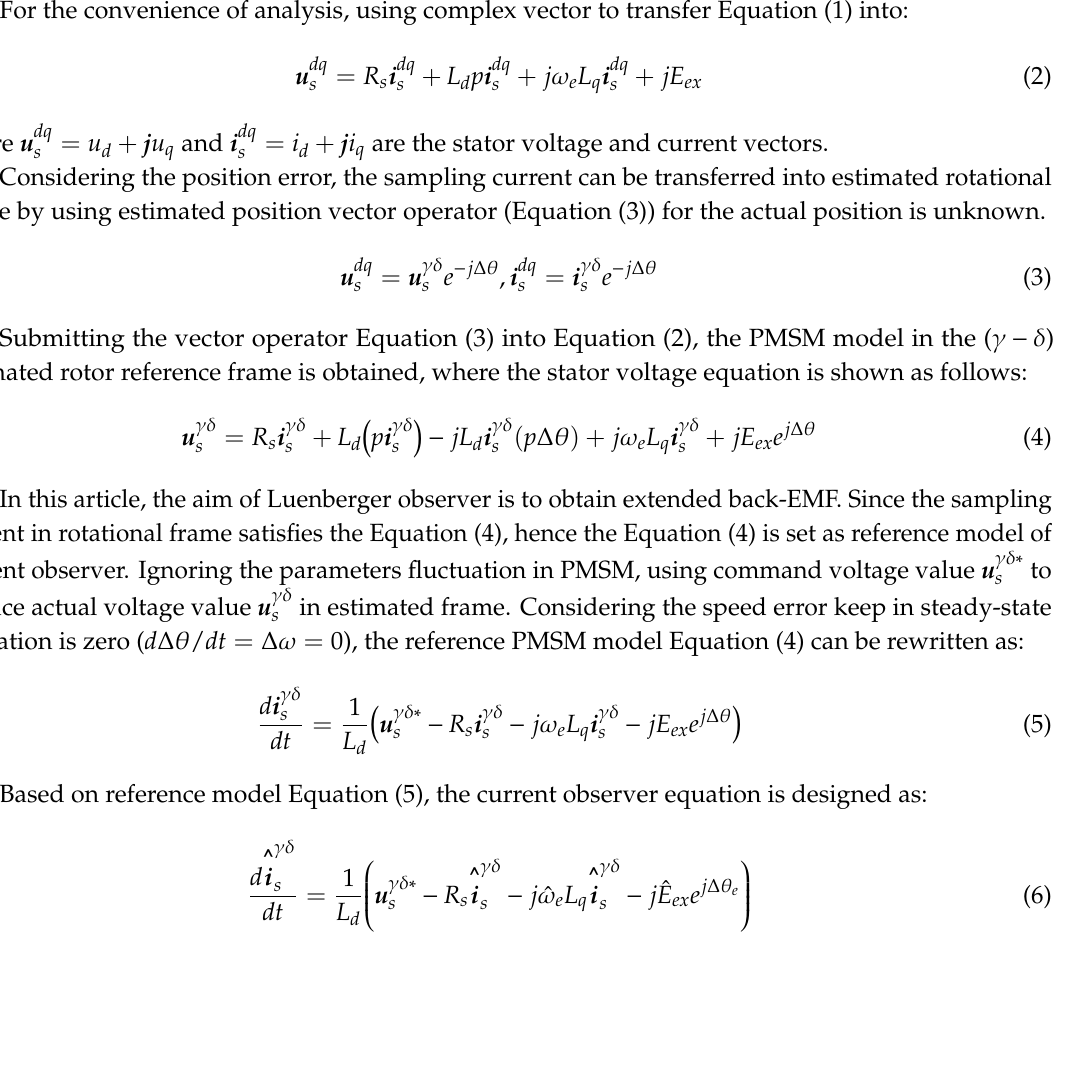
i and i are d q